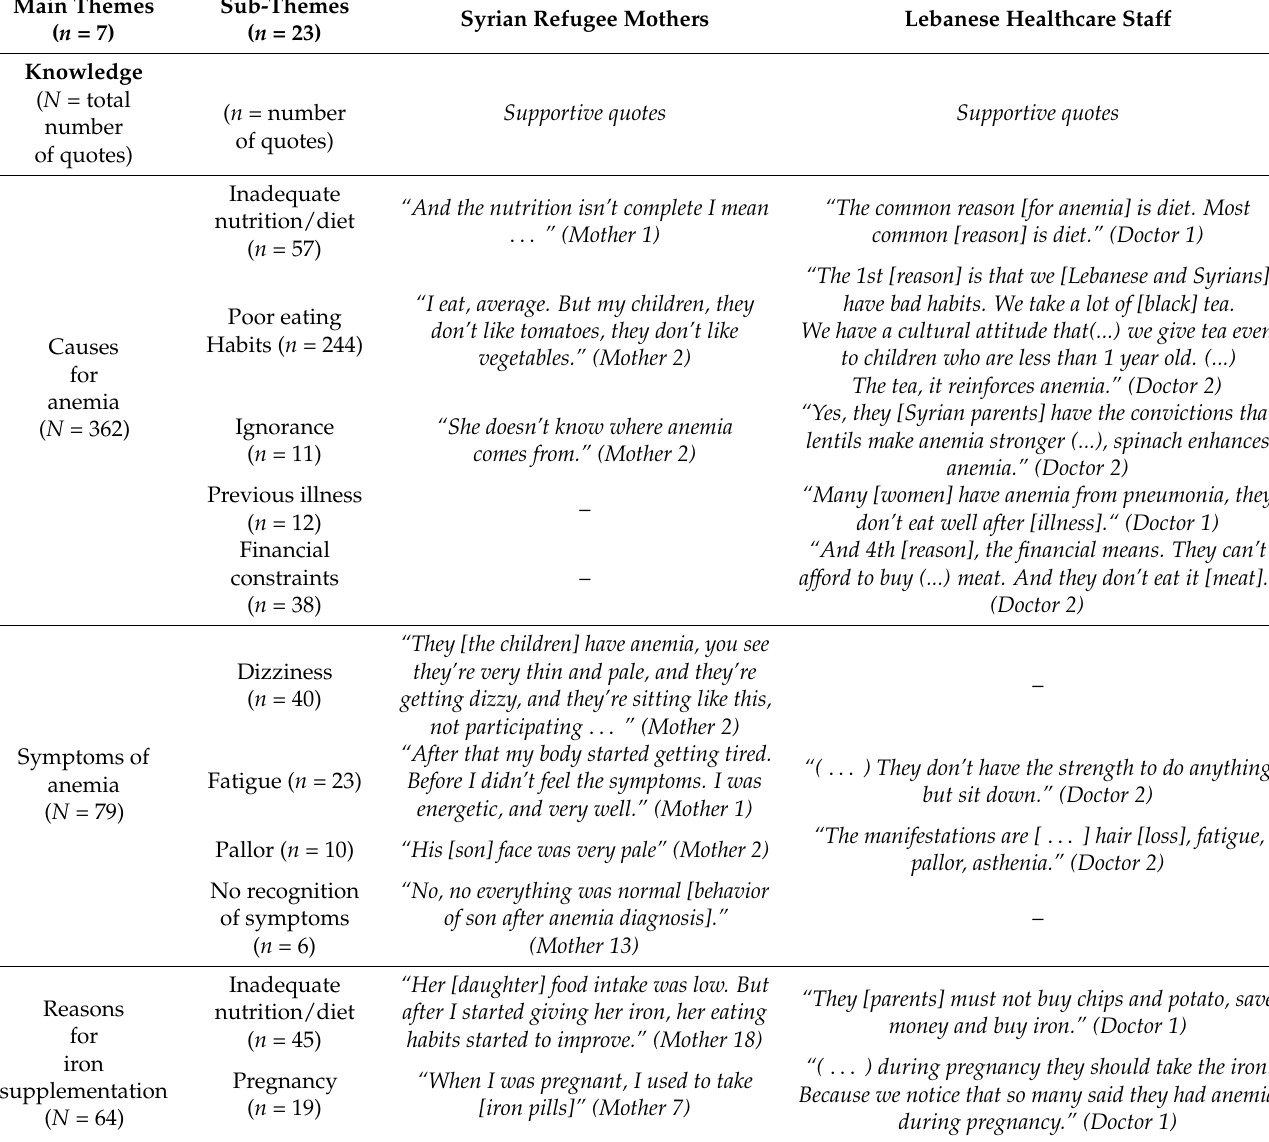
Table 8. Knowledge, attitudes and perceptions on anemia and its treatment options of mothers of (Qualitative Assessment, Source: 11 FGD and 4